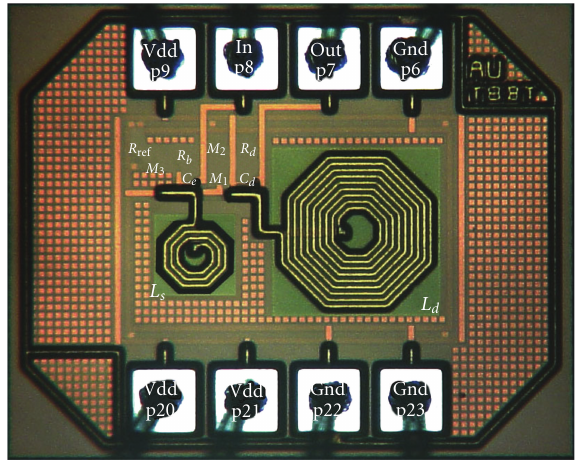
Figure 4: Microphotograph of the fabricated RFID LNA.